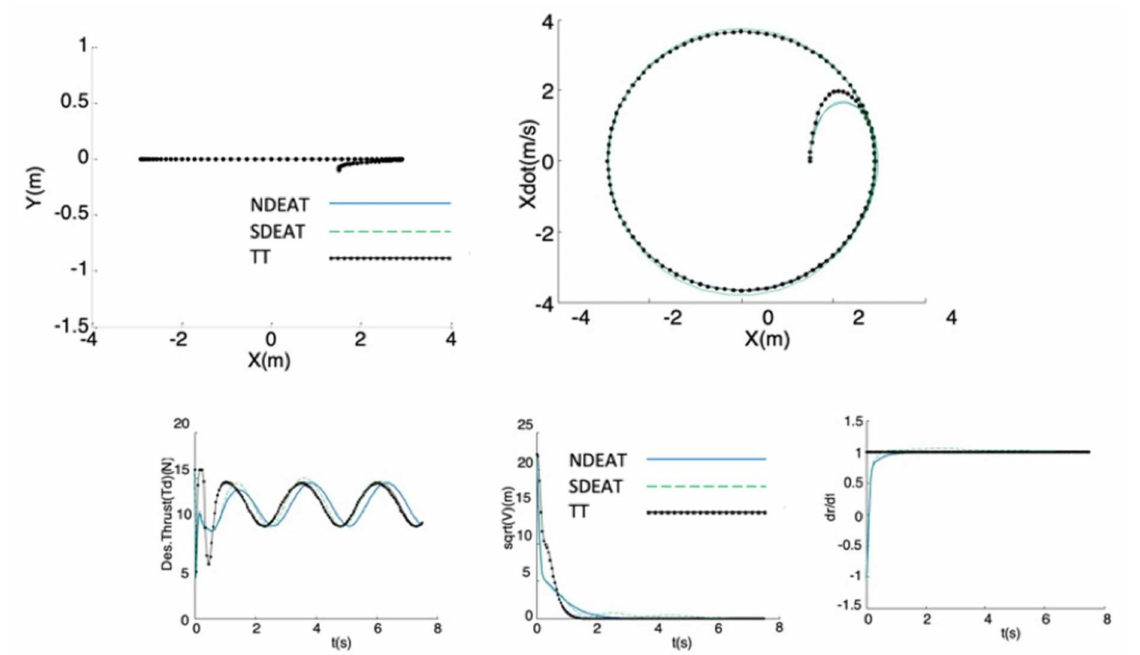
Figure 5. Comparison of NDEAT, SDEAT and TT when the robot is ahead (same desired path as previous Figure 4). Up : Left , Y/X trajectories; Right : evolution of Td (with saturation). Middle : Lyapunov function versus time. Right : evolution of σ = dr / dt with respect to time.